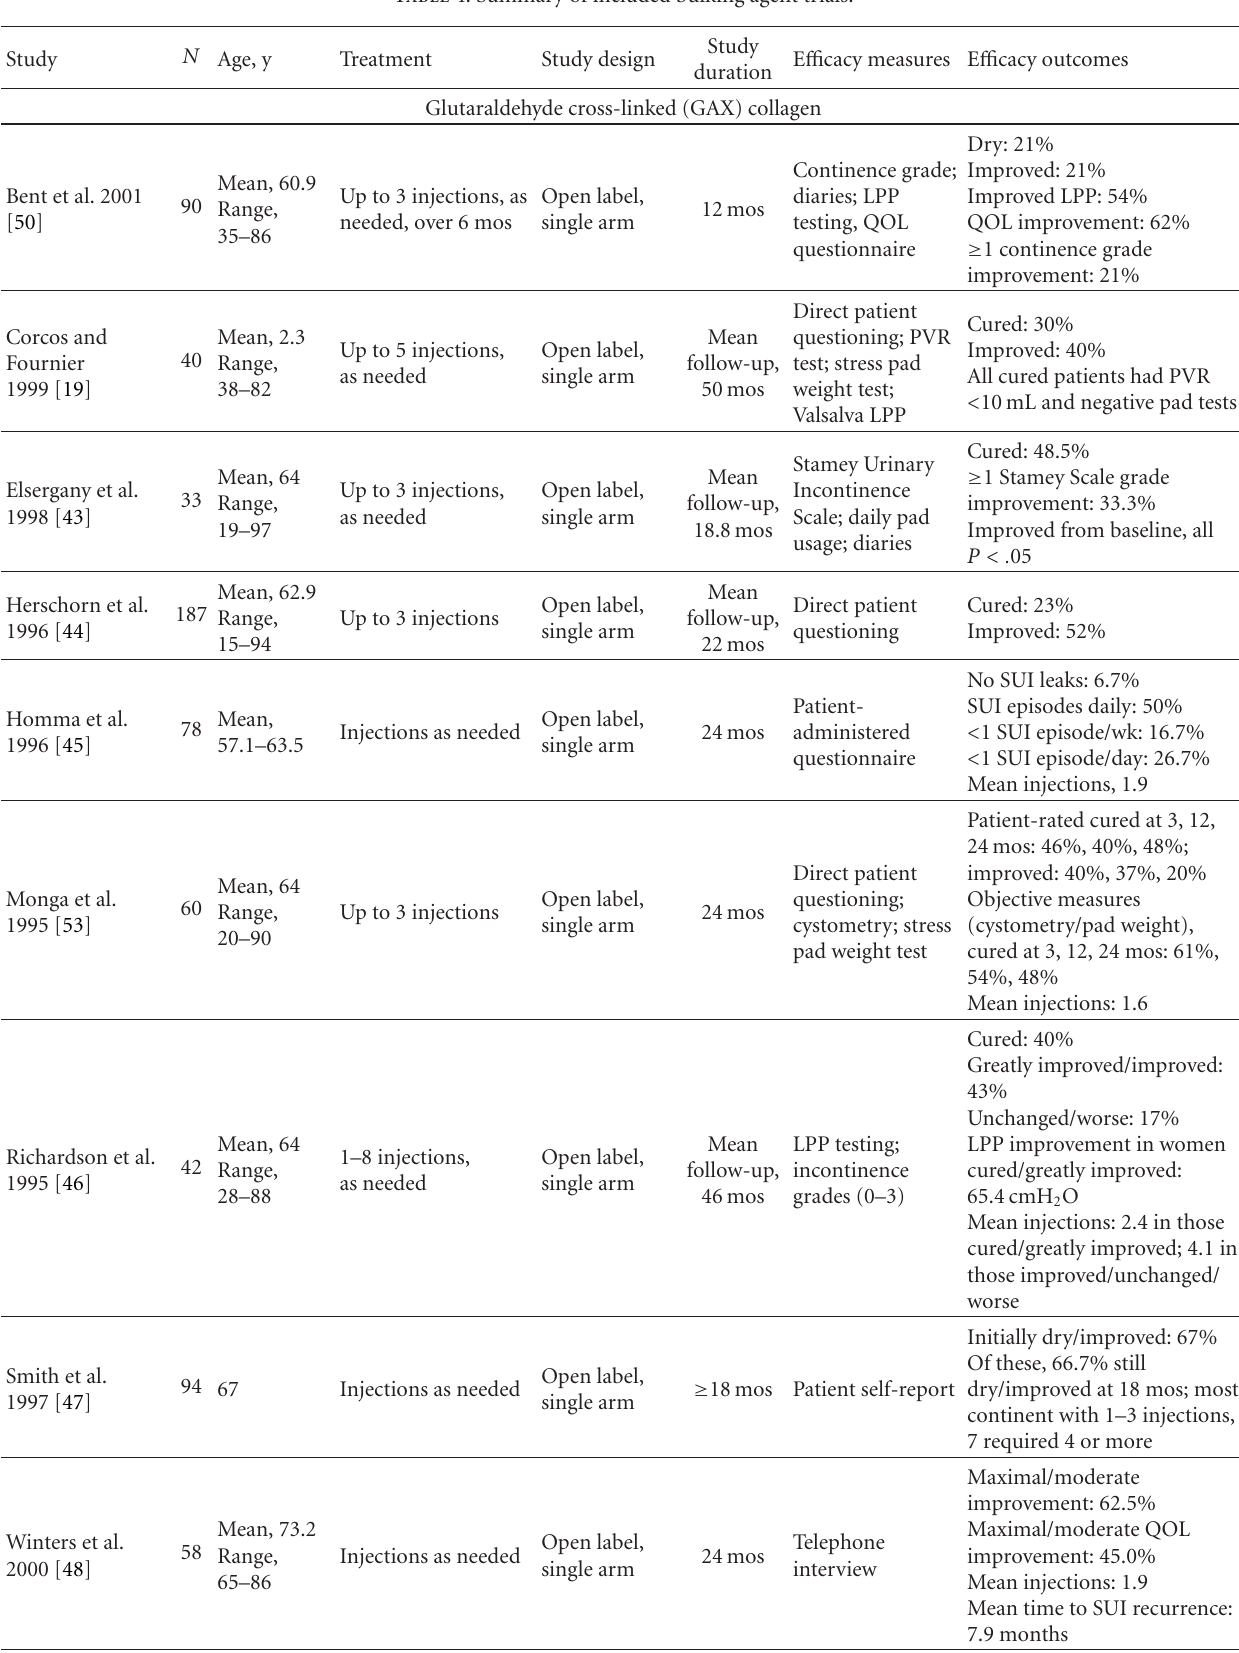
Table 4: Summary of included bulking agent